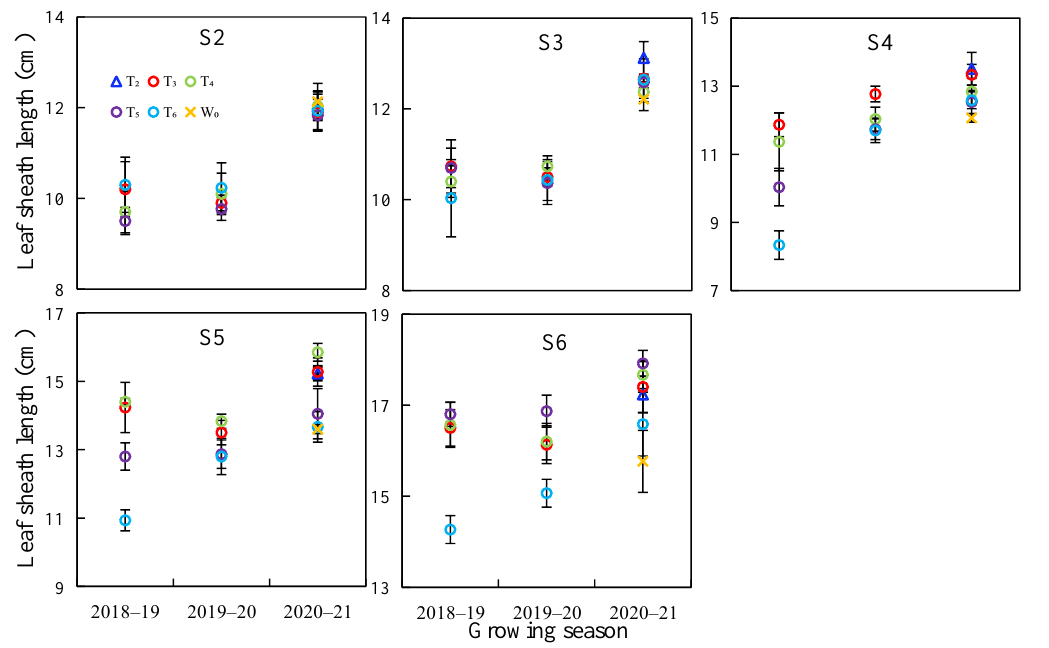
Figure 4. Leaf-sheath length for different treatments in each wheat growing season. S2 – S6 represent the second leaf sheath to the sixth leaf sheath in springtime. T 2 was not set in the growing seasons